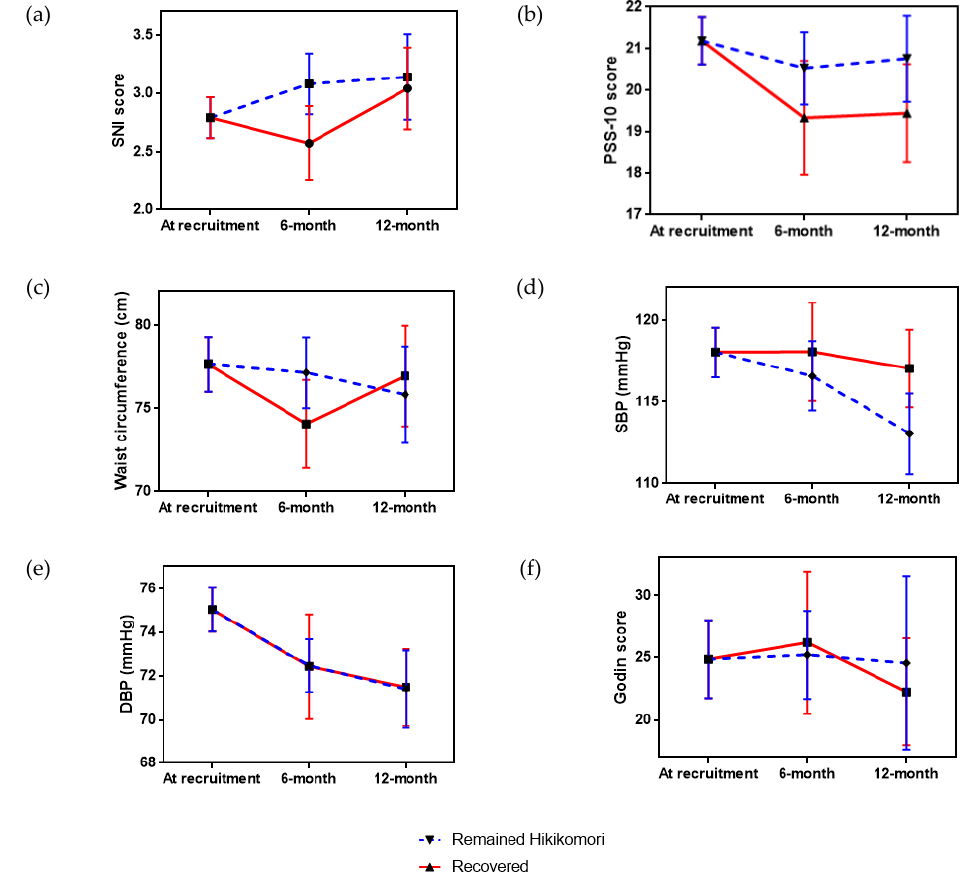
Figure 2. Comparison of the pattern changes among significant variables ( a ) SNI score; ( b ) PSS-10 score; ( c ) waist circumference; ( d ) SBP; ( e ) DBP; ( f ) Godlin score between the participants remained as hikikomori and those recovered from hikikomori. SNI: Social Network Index; PSS-10: 10-item Perceived Stress Scale; SBP: systolic blood pressure; DBP: diastolic blood pressure.